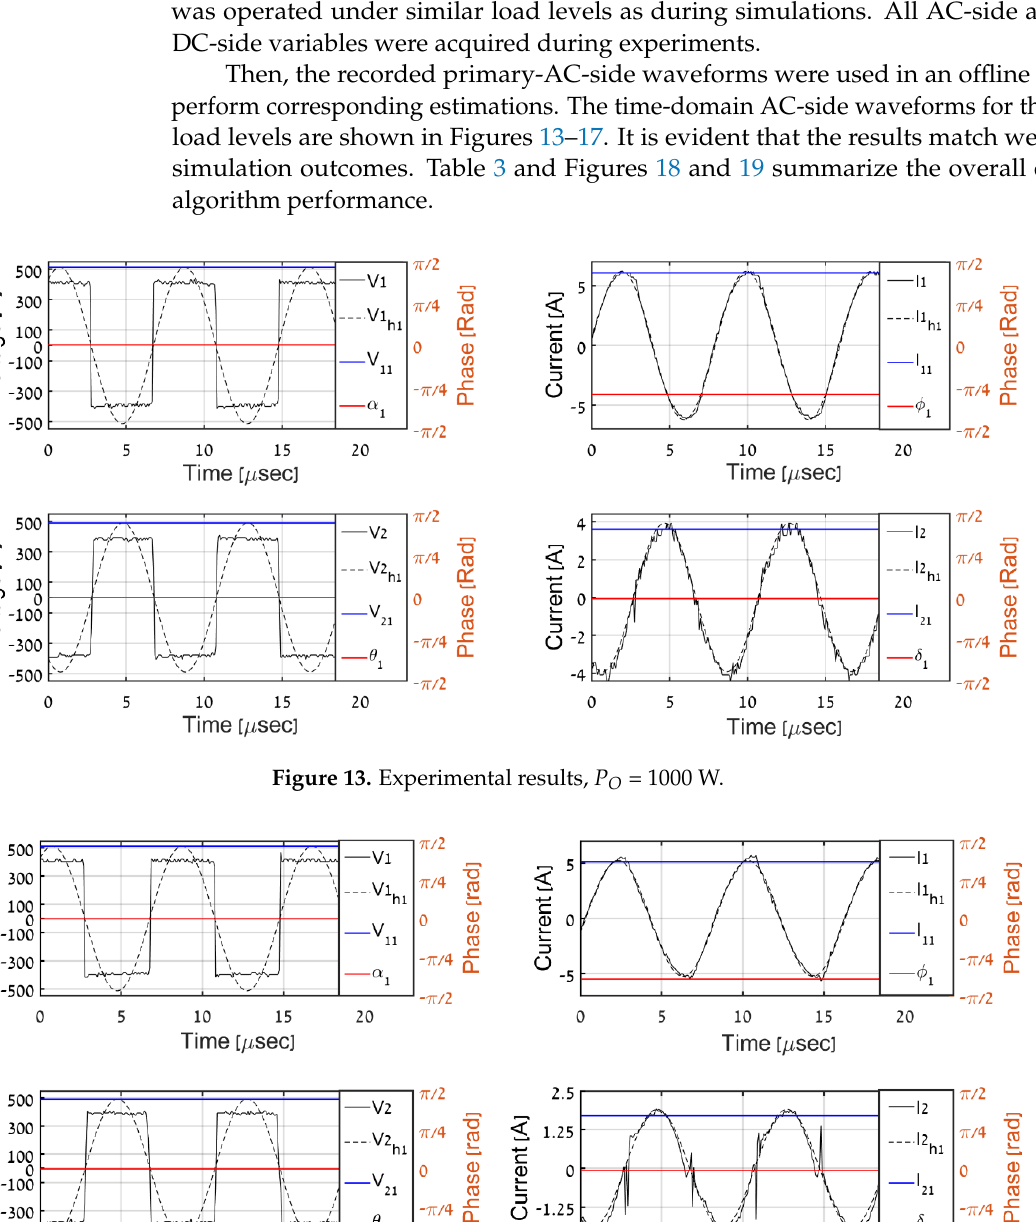
Figure 14. Experimental results, P O = 500 W.